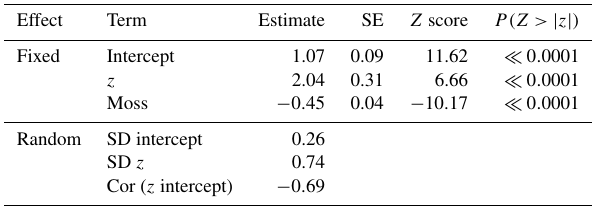
Table 3. Cumulative sum of basal area by hummock and hollow across